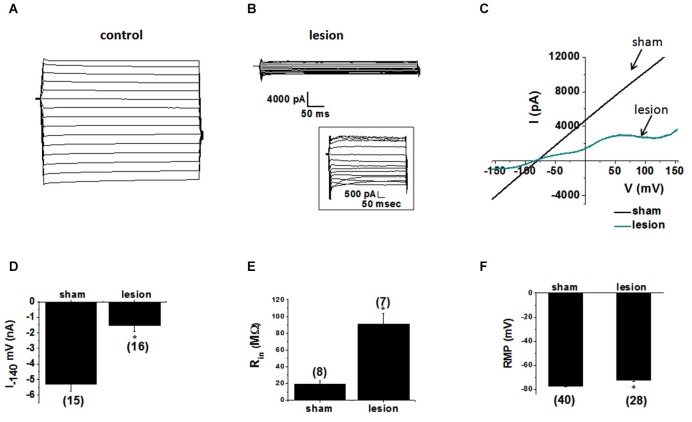
Astrocytes in the hyperexcitable zone display altered electrophysiological properties. (A) Representative whole-cell current responses to a voltage step protocol in an astrocyte in a slice from a sham-operated control and (B) a recording obtained from an astrocyte in slice from a lesioned animal. Inset shows current displayed at higher resolution. (C) Representative whole-cell currents from sham-operated (black) and lesioned (blue) astrocytes in response to a linear voltage ramp (−160 to +160 mV). (D) Bar graph showing differences in the mean current amplitude obtained from the voltage step protocol (at −140 mV) in control and lesioned astrocytes. (E) Bar graph showing the input resistance in astrocytes in lesioned animals was significantly higher (90.9 ± 13 MΩ) than that of control animals (19 ± 5 MΩ). (F) The resting membrane potential was significantly depolarized in astrocytes from lesioned animals (−71 ± 1.4 mV) relative to control astrocytes (−77 ± 0.77 mV).